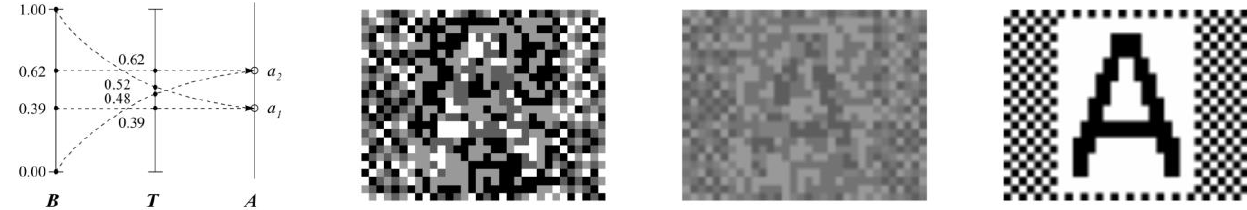
Figure 8. Bias-scrambling, trigger-scrambling. Left: diagram of rule set f 4 , with arrows linking the intensities that are used. Middle, left and right: the scrambled bias and trigger images from an image sequence generated by rule set f 4 . Right: the target afterimage pattern, with a 1 shown as black and a 2 shown as white .